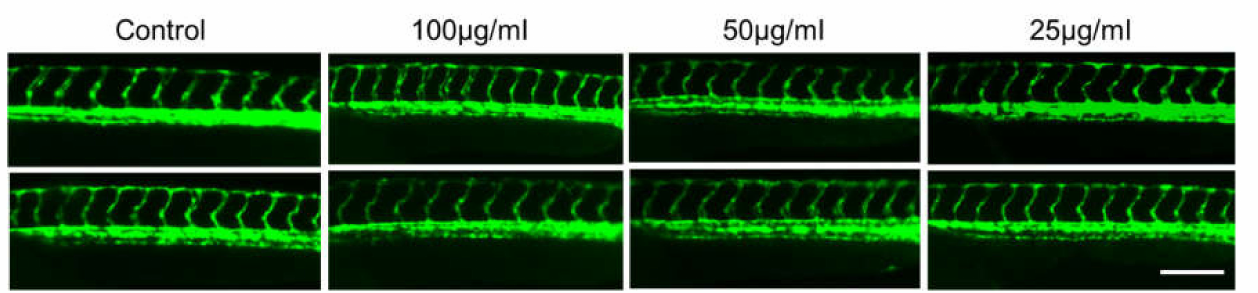
Figure 18. Effects of CTF_EA at different concentrations of 100 µ g/mL, 50 µ g/mL, and 25 µ g/mL on blood vessel development in transgenic zebrafish, Tg(kdrl:egfp) at 30 hpf. Vasculogenesis and angiogenesis in the trunk region were normal in both control and CTF_EA-treated zebrafish. Scale bar, 200 µ